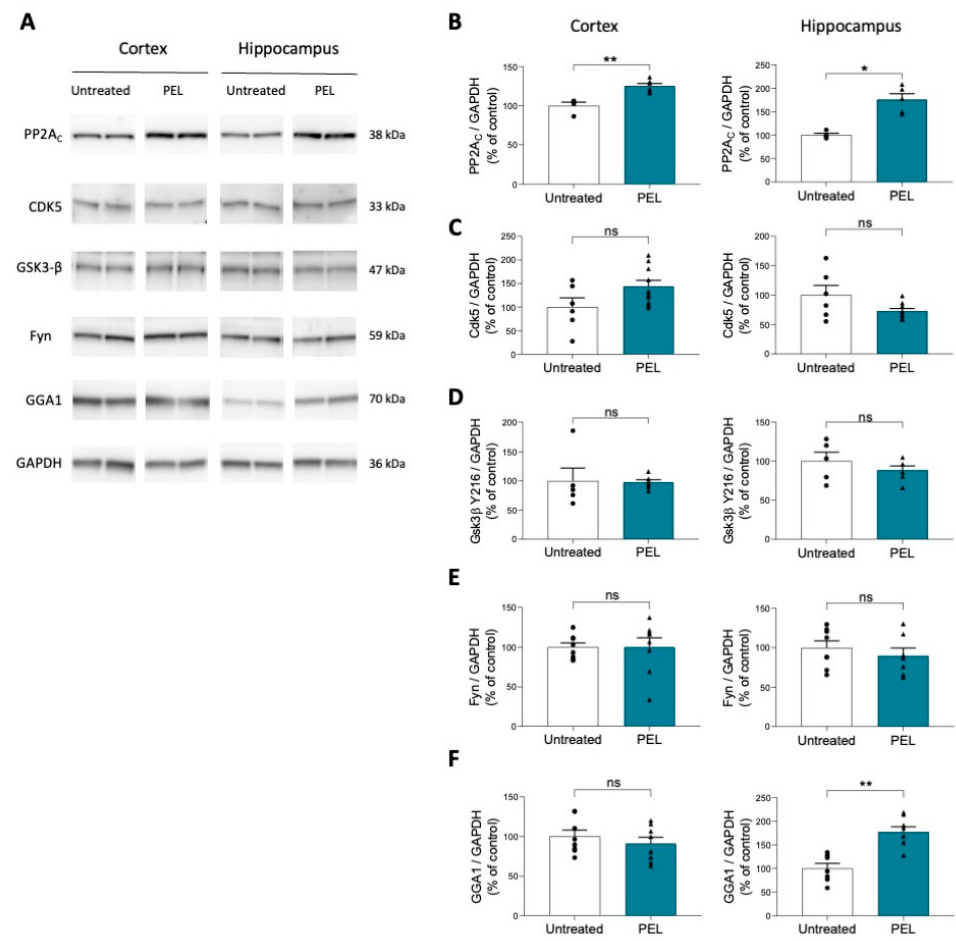
Figure 4. PEL24-199 treatment increases PP2AC and GGA1 protein expression in APP/PS1 mice ( A ). Western blot analysis was performed in the cortex and hippocampus of water- and PEL24-199-treated APP/PS1 mice. ( B – F ) Histograms representing PP2AC, Cdk5, Gsk3- β , Fyn, and GGA1 protein levels in the cortex and hippocampus of PEL24-199-treated and untreated APP/PS1 mice. PP2AC expression was significantly increased both in the cortex and in the hippocampus, and GGA1 expression was elevated in the hippocampus. The analysis did not reveal any change in Cdk5, Gsk3- β , and Fyn expression (n = 4–8 per group). Significance at the Mann-Whitney statistical test is indicated by *: p < 0.05; **: p < 0.01 and ns as not significant.